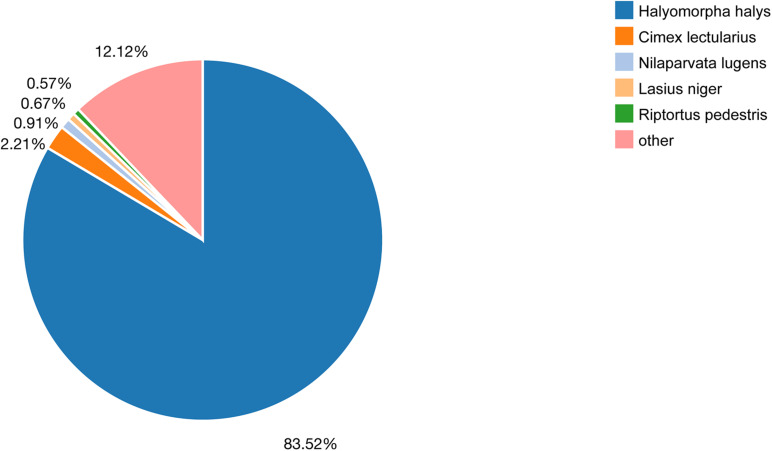
Species distribution of the unigenes within the A. chinensis antennal transcriptome based on the results of a BLASTX search. Different colors represent different species.